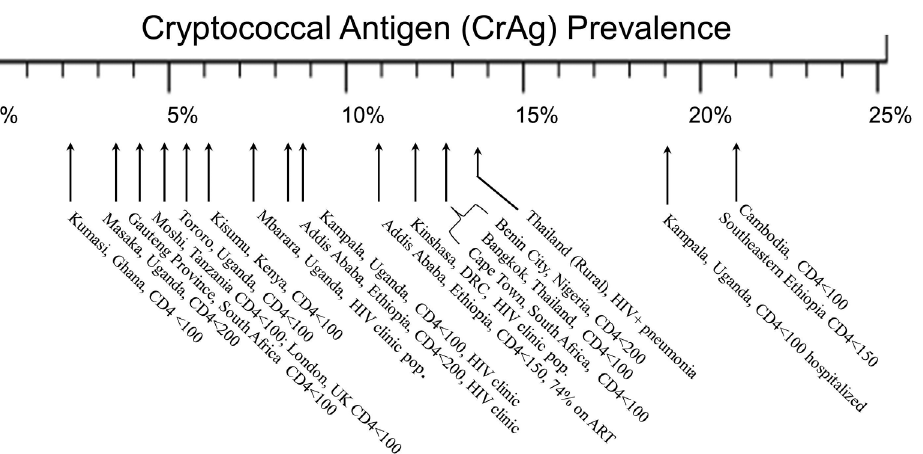
Figure 1. Cryptococcal Antigen Prevalence in Reported Cohorts. The prevalence of cryptococcal antigenemia was 21% among those with CD4 count , 150 cells/ m L, irrespective of ART status, in this two-site study in southeastern Ethiopia. This prevalence is similar as in Cambodia 21.0% [18] but higher than reported from Addis Ababa, Ethiopia [26], Uganda [10,13,19,20], Thailand [9], Ghana [21], Tanzania [22], Democratic Republic of the Congo (DRC) [23], Cape Town, South Africa [12], Nigeria [24], Vietnam [27], and in a pneumonia cohort from Thailand